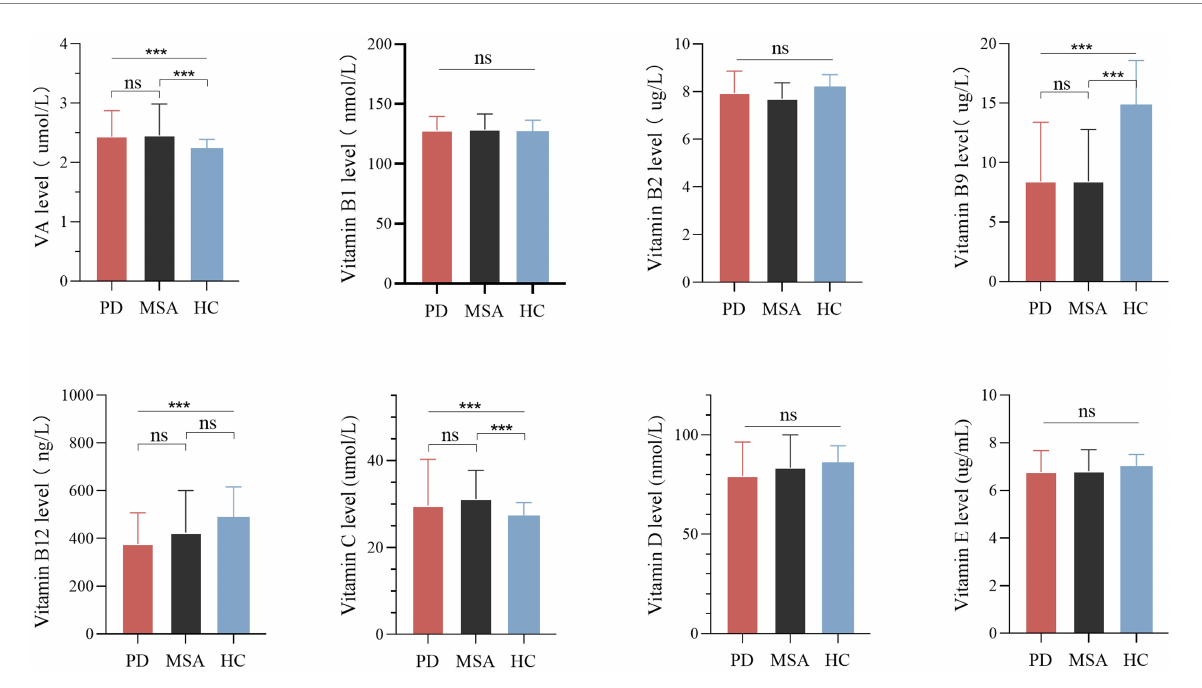
FIGURE 1 Levels of different vitamins in patients with multiple system atrophy (MSA), Parkinson’s disease (PD), and healthy controls (HC). Multiple comparisons were corrected with Bonferroni correction. ns: non-significant. *** p < 0.001.